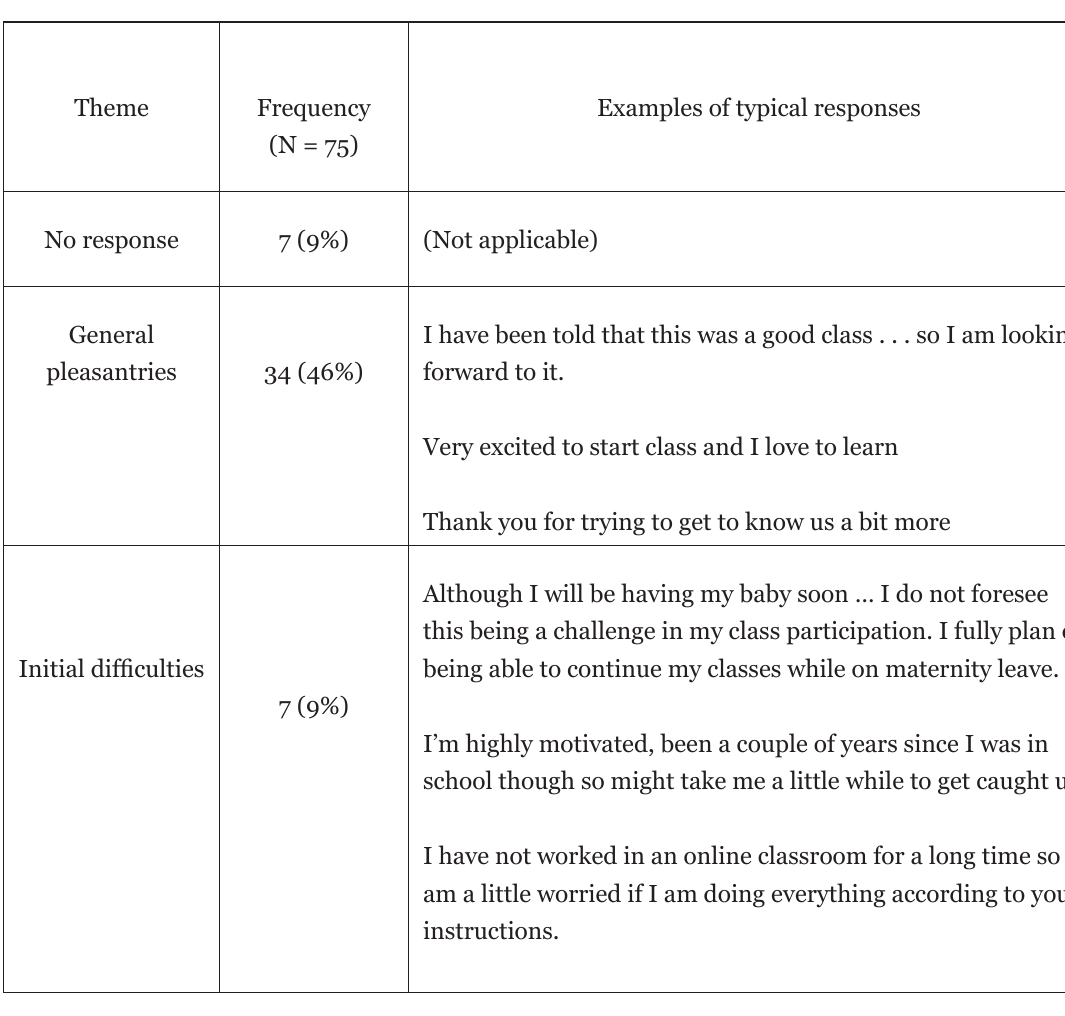
Emergent Themes, Relative Frequencies, and Representative Excerpts from Student Re-